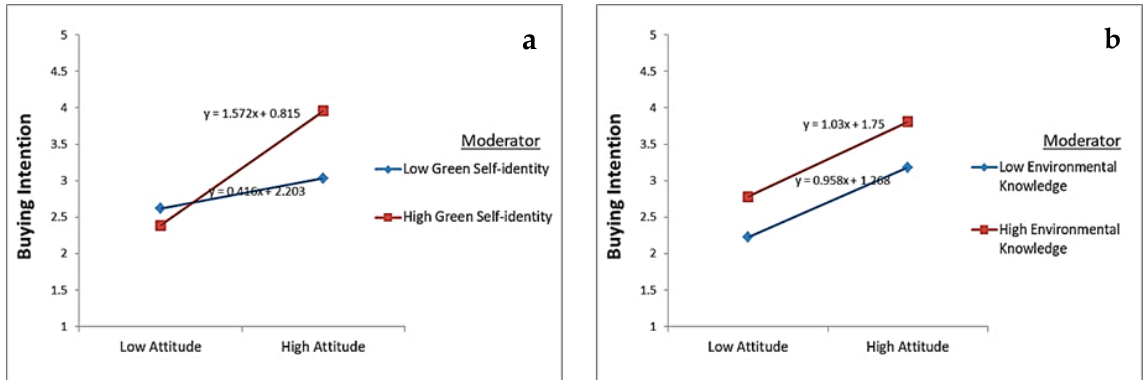
Figure 4. Interaction of ( a ) green self-identity is significant ( b ) environmental knowledge is insignificant between attitude and buying intention relationships, Source: Sobel test output.